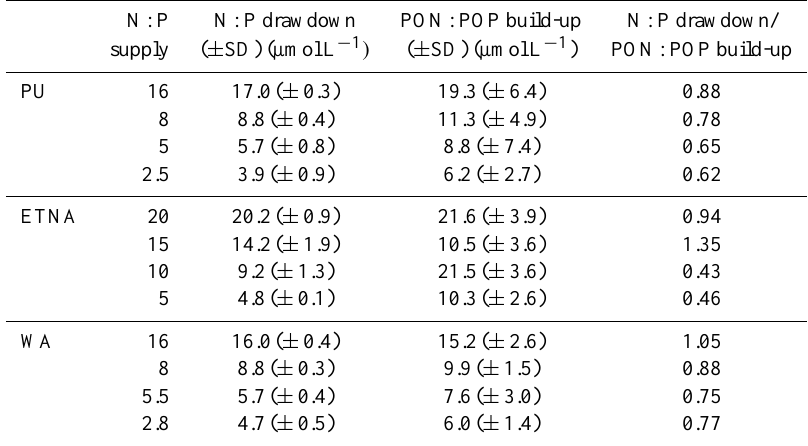
Table 4. Summary of the N : P uptake and the stoichiometry of particulate organic matter build-up within each experiment. The quotient of N : P drawdown and PON : POP build-up describes the analogy of N : P uptake and produced PON : POP. N : P N : P drawdown PON : POP build-up N : P drawdown/ supply ( ± SD) (µmolL − 1 ) ( ± SD) (µmolL − 1 ) PON : POP build-up PU 16 17.0( ± 0.3)